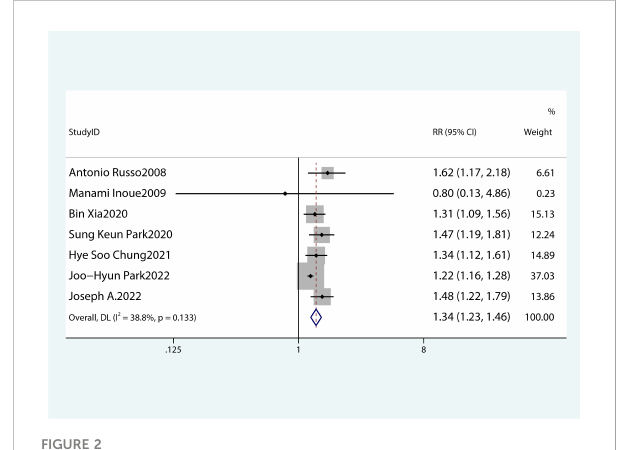
FIGURE 2 Meta-analysis of studies on the correlation of metabolic syndrome with pancreatic cancer;.